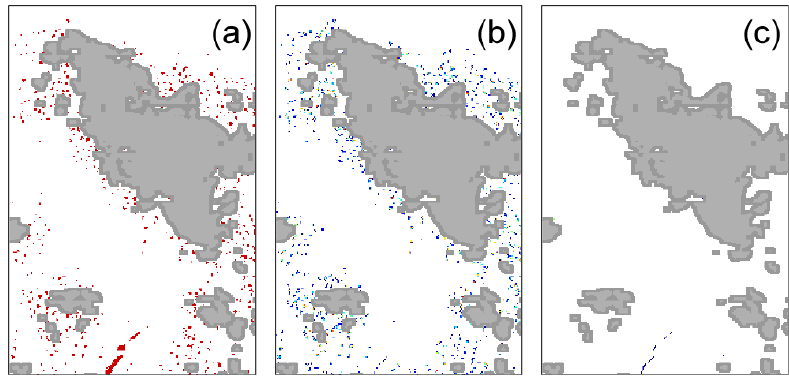
Figure 6. MODIS tile “A2007290.0355” zoom of the red square area (24 ◦ S, Fig. 5). Pixels resulting from a false positive detection of (a) the McKinna modified algorithm, (b) FAI, and (c) the new algorithm for the area in red in Fig. 5. Cloud pixels are in grey.